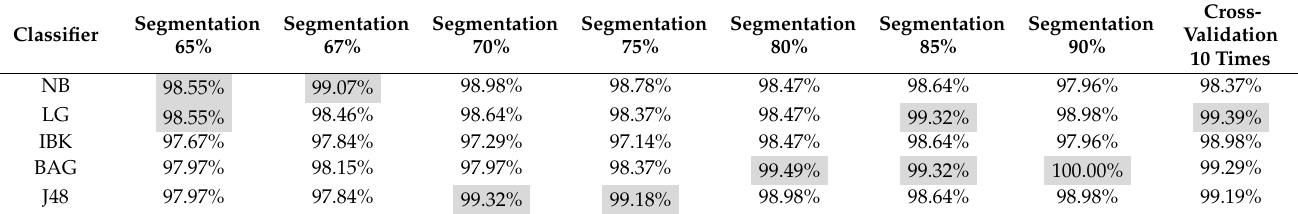
Table 6. The classifier accuracy of feature selection for 491 normal and 491 bankrupt companies (1:1). Segmentation Classifier